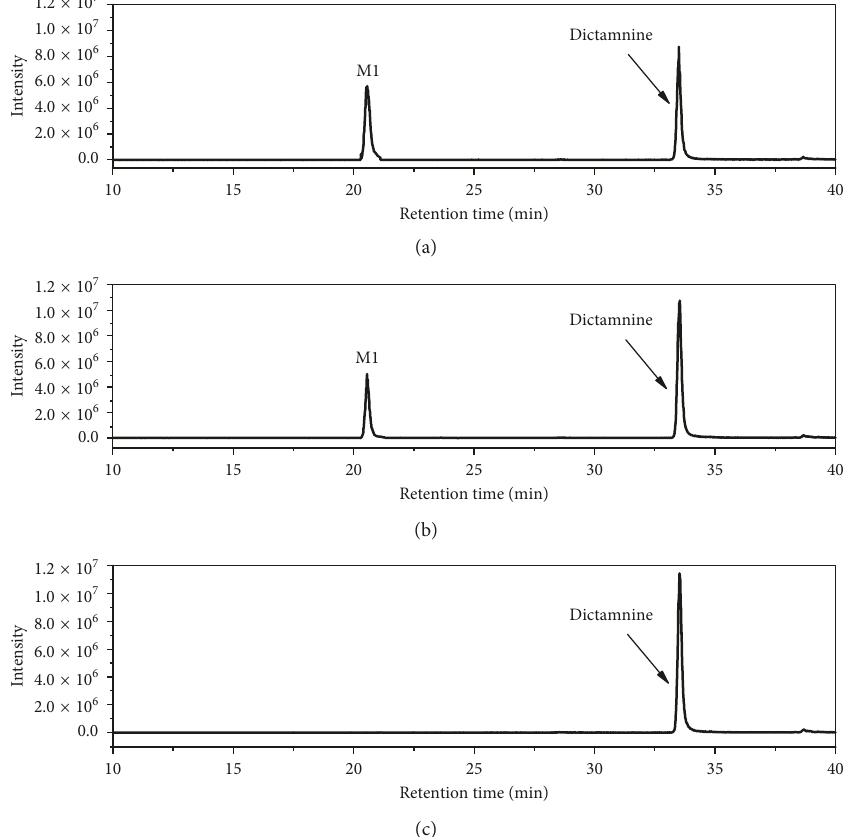
Figure 5: Representative extracted ion chromatograms of microbial metabolites of dictamnine after incubating with pooled human fecal slurry. (a) 24 h; (b) 12 h; (c) control.